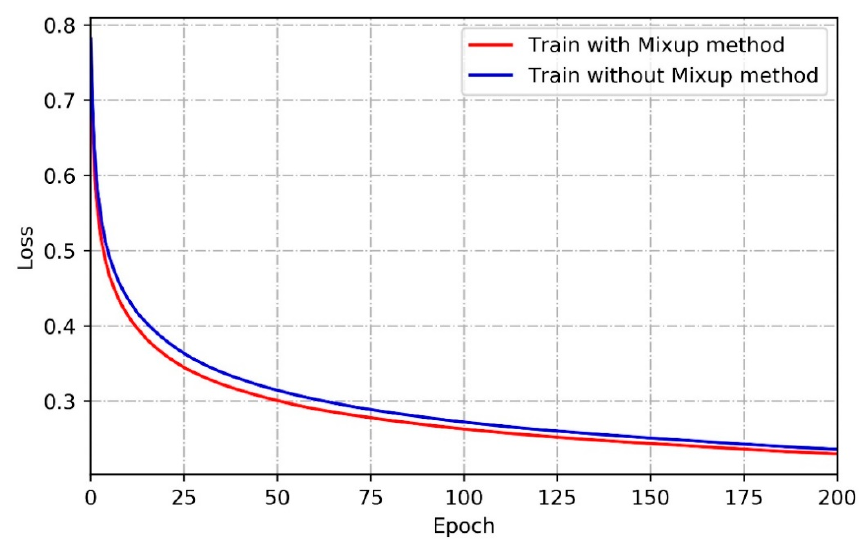
Figure 15. Loss curves of the two methods.